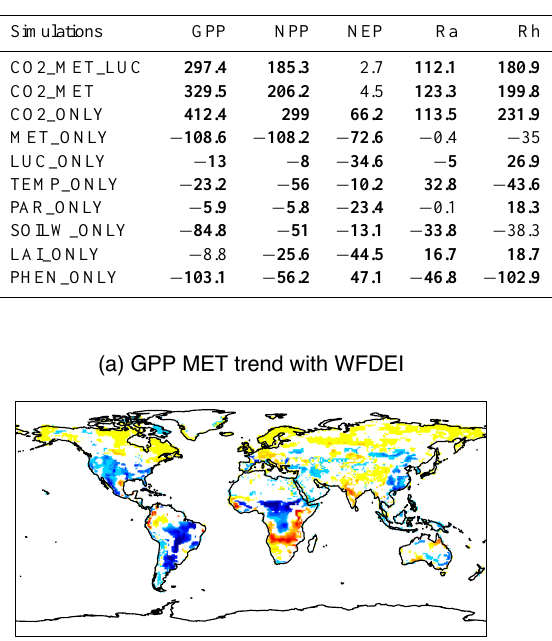
Table 3. Summary of simulated trends of global carbon fluxes (Tg Ca − 2 ) from different experiments. Simulations are using WFDEI meteorology. Significant trends ( p < 0 . 05) are shown in bold.